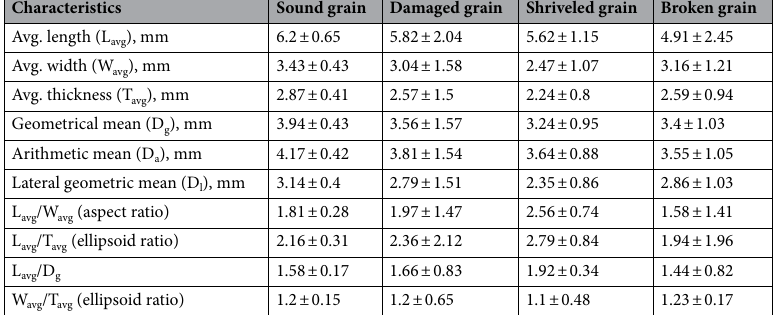
Table 5. Axial dimensions of different grain fractions of selected wheat variety (n = 100).